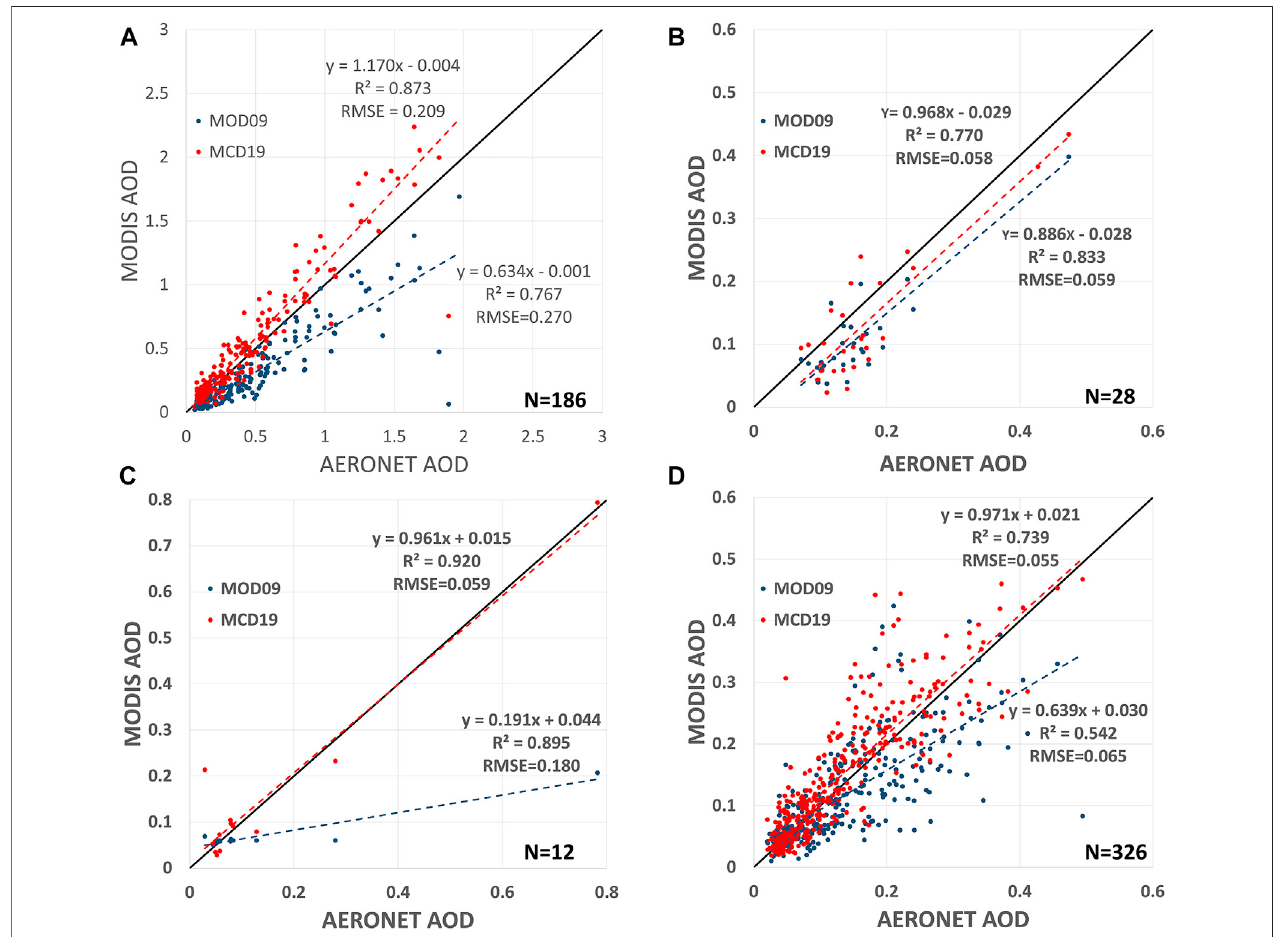
FIGURE 9 | AOD 0.47 validation for MCD19 and MOD09 for XiangHe, XuZhou-CUMT H27V05 (A) , Rio_Branco, H11V09 (B) , Pickle_Lake, H12V03 (C) and Appalachian_State, Dayton, EPA-Res_Triangle_Pk, IMPROVE-MammothCave, NASA_LaRC, NEON_MLBS, NEON_SCBI, NEON_ORNL, H11V05 (D) AERONET sites. N gives the total number of AERONET match-up points for each tile. The black line shows a 1:1 correspondence to AERONET.